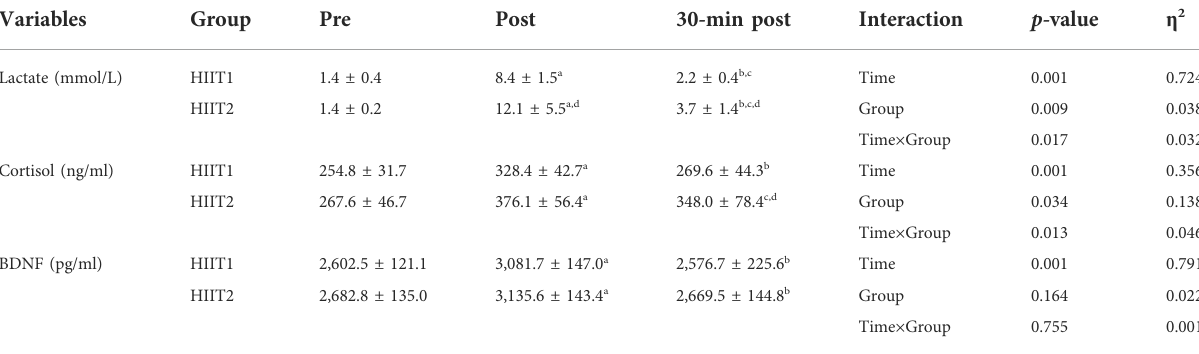
TABLE 2 Blood lactate, serum cortisol and BDNF responses measured at the assessment time-points.